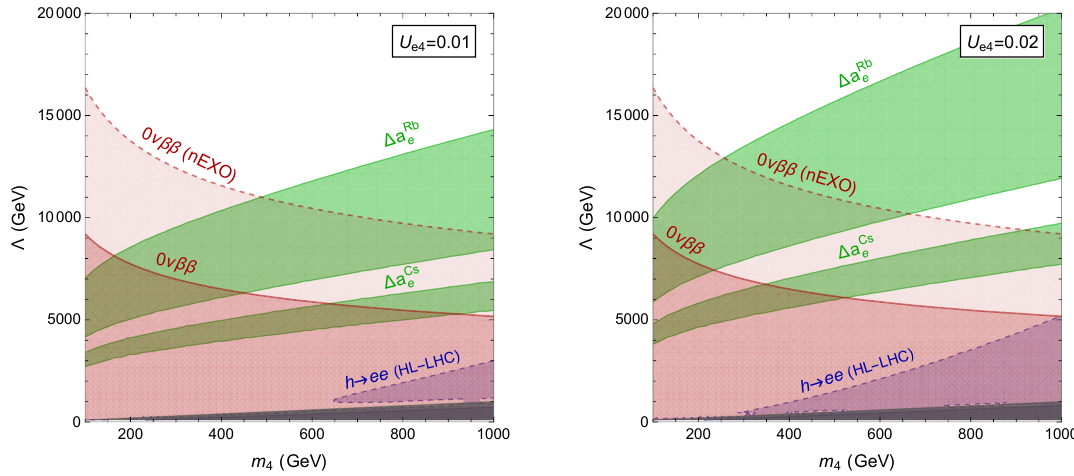
Figure 6 . The upper (lower) green area depicts parameter space in the m 4 - Λ plane that can account for the ∆ a Rb ( ∆ a Cs ) discrepancy for a mixing angle U e 4 = 0 . 01 (left panel) and U e 4 = 0 . 02 (right e e panel). The red region depicts the excluded area due to 0 νββ and the blue regions are excluded by measurements of the h → ee branching ratio. The red and blue dashed lines show prospects for future 0 νββ experiments and the high-luminosity LHC. The gray area shows the region with m 4 & Λ , where the ν SMEFT approach breaks